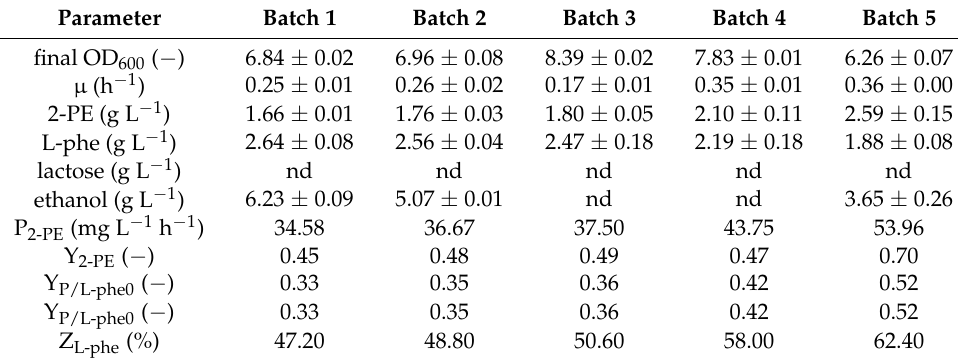
Table 3. Parameters of 48 h batch cultures of K. marxianus WUT240 producing 2-PE in WP2 medium